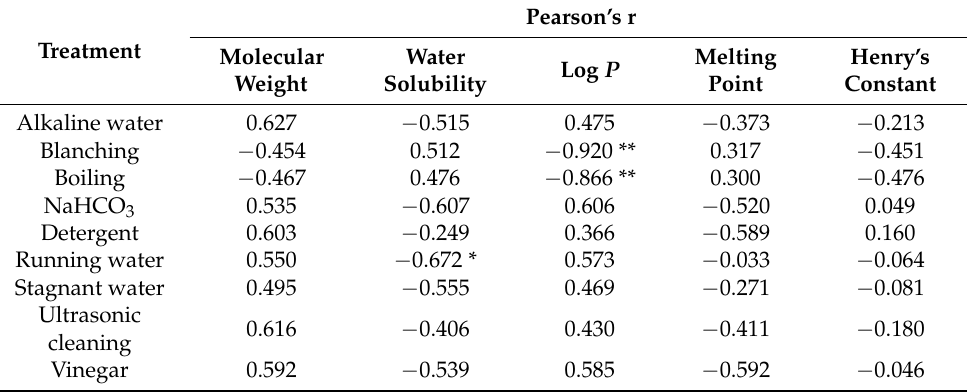
Table 5. Correlation analysis between nine washing methods and properties of pesticide.